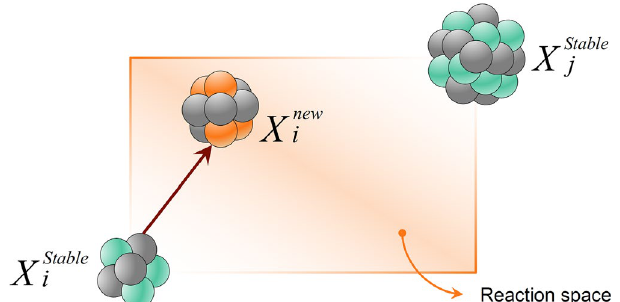
Figure 5. Schematic representation of a fission reaction.